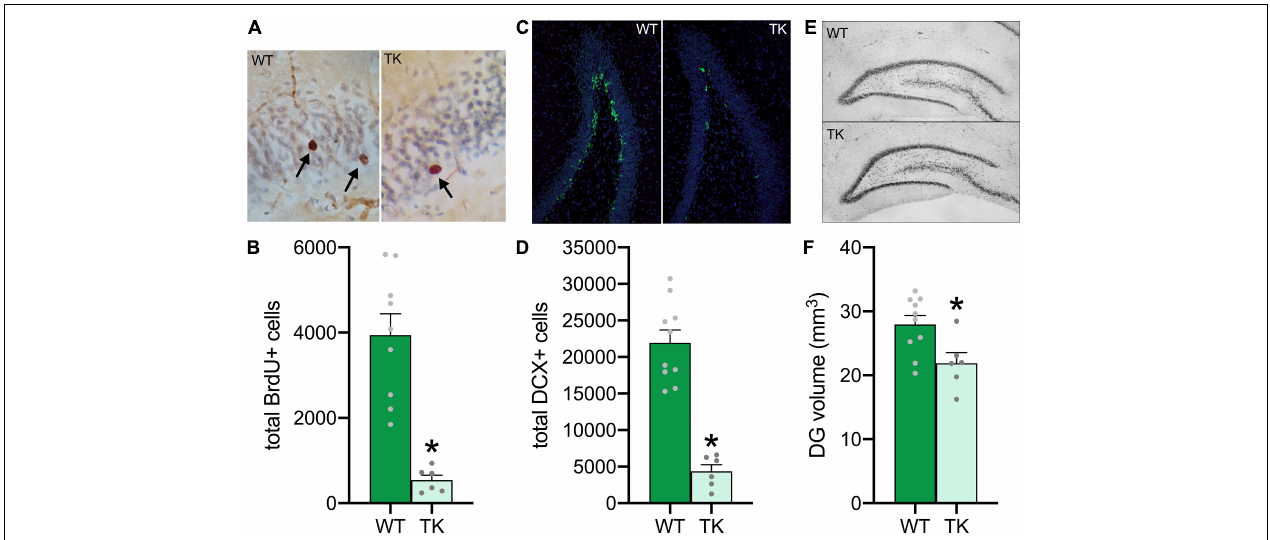
FIGURE 2 | Knockdown of adolescent neurogenesis negatively affects hippocampal structure in adulthood. (A) Representative images of BrdU-labeled cells at 40x zoom. (B) Transgenic (TK) rats had cell proliferation inhibited during adolescence. (C) Representative images of DCX-labeled cells at 10x zoom. (D) TK rats had decreased neurogenesis during adulthood. (E) Representative images of Nissl stains at 4x zoom for dentate gyrus volume estimation. (F) TK rats had decreased volume of the dentate gyrus. * p < 0.05 compared to WT. All bars represent S.E.M. and dots represent individual rat data.